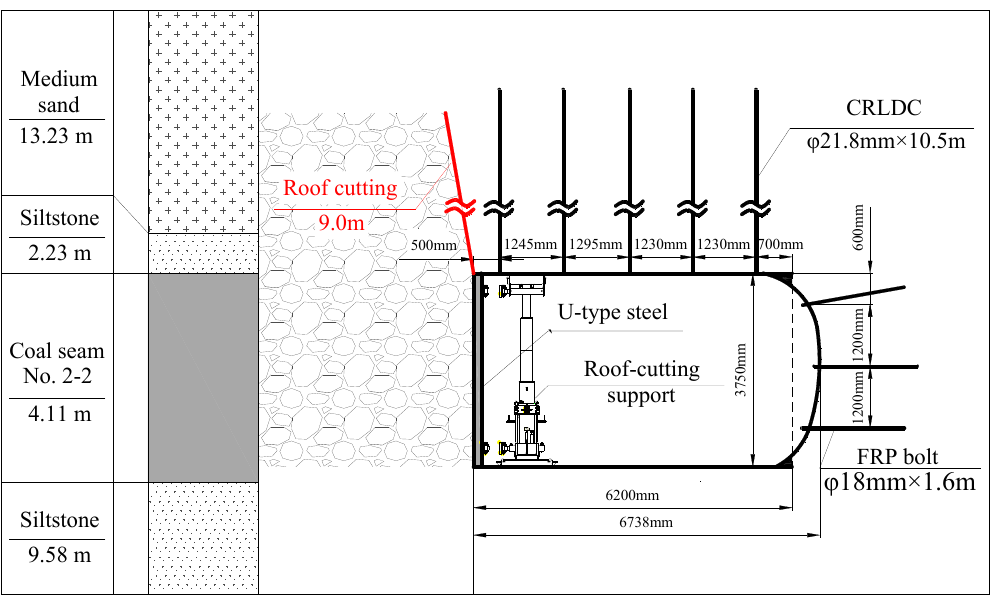
Figure 13. Roof-cutting and support parameters for the retained entry.